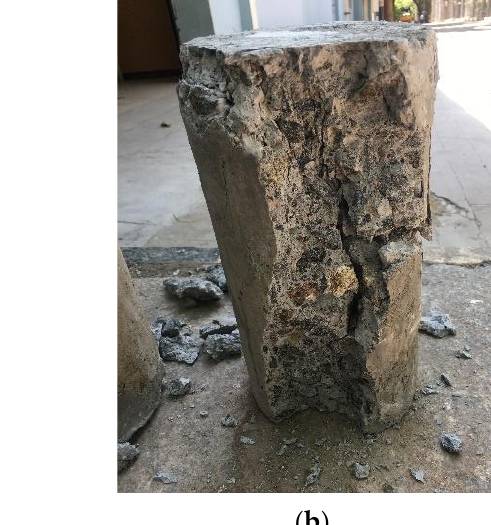
10 of 21 Figure 5. Derivative thermogram of composites. 3.2. Phase 2: Failure Modes and Compressive Behavior of Concrete Specimens 3.2.1. Unconfined Specimens The unconfined cylinders were exposed to five temperature regimes viz. room tem- perature, 100 °C, 200 °C, 300 °C, and 400 °C. The failure of unconfined specimens under axial loading after exposure to high temperatures was predominantly due to the splitting of outer concrete layers. Figure 6 displays the failure patterns of unconfined cylinders af- ter compression testing. Cracking along with concrete spalling was observed over the con- crete surfaces [39]. The average unconfined concrete strength at ambient temperature was 14.9 MPa as seen in Table 4. The core strength was reduced by 5%, 13%, 18% and 30% at 100 °C, 200 °C, 300 °C, and 400 °C respectively. It may be noticed that exposure to elevated